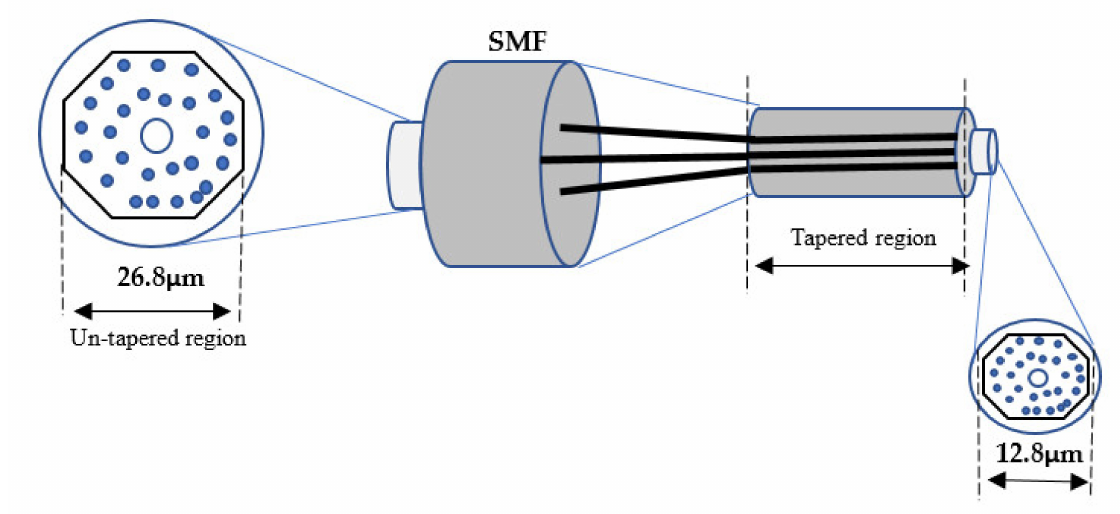
Figure 6. Tapered fiber based on photonic crystals fiber (PCF)